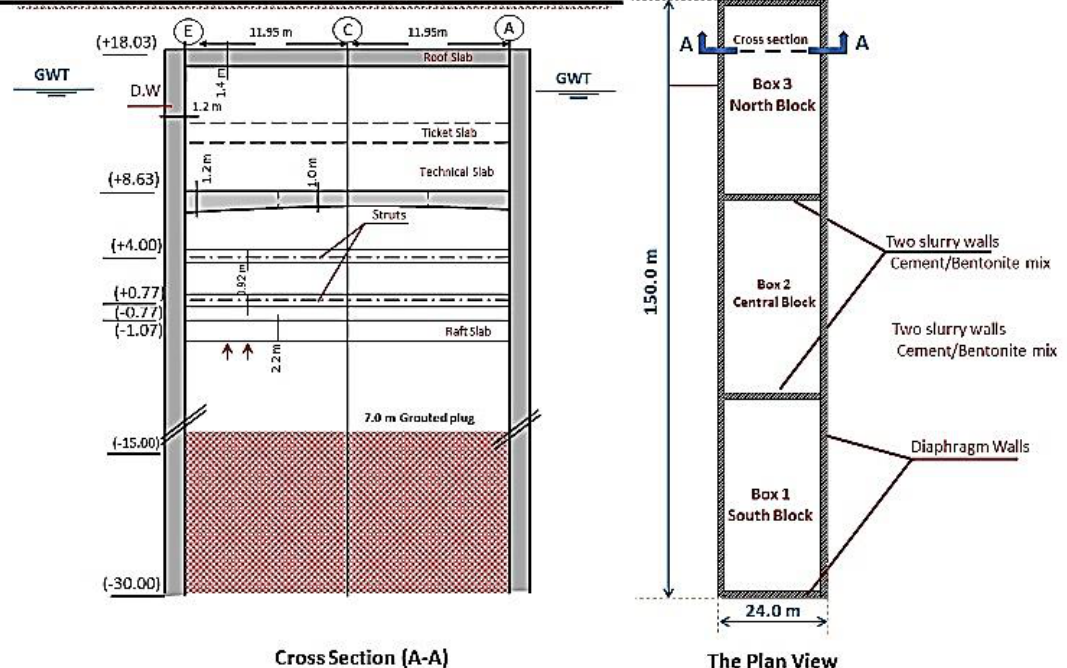
Figure 1. Layout and cross-section of Rod El-Farag subway station [30].